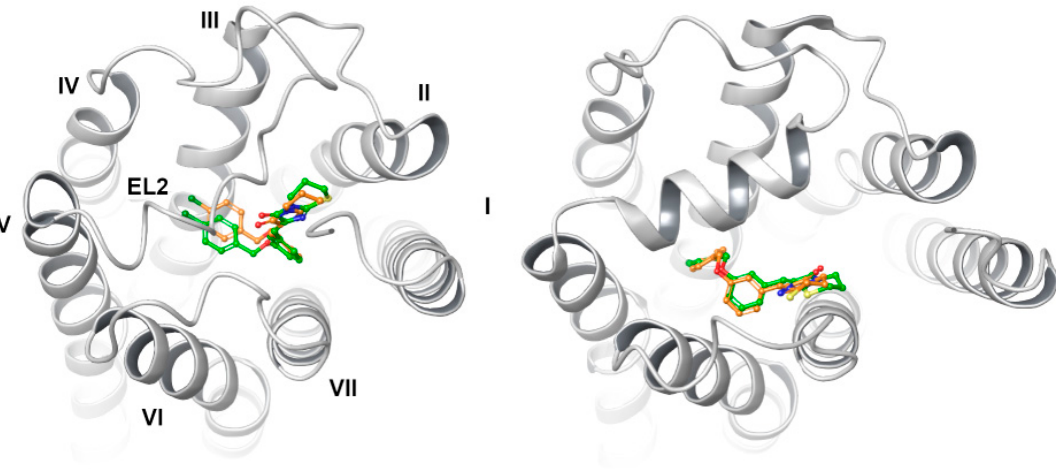
Figure 9. Comparison of putative binding modes of CB5 calculated with DT (green) and GWO (orange) to the TTA ( left ) and PF-DM ( right ) models. Roman numerals indicate TMs—only marked in the TTA model for clarity purposes. For a colored figure, please refer to the online version of this paper.